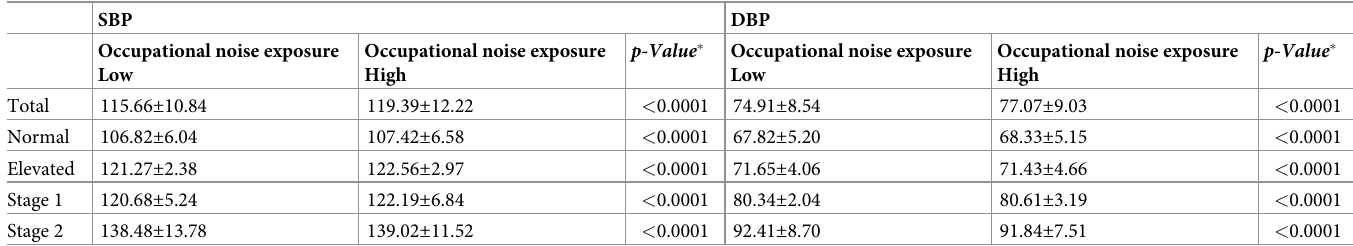
Table 2. Descriptive statistics of SBP and DBP by noise exposure.